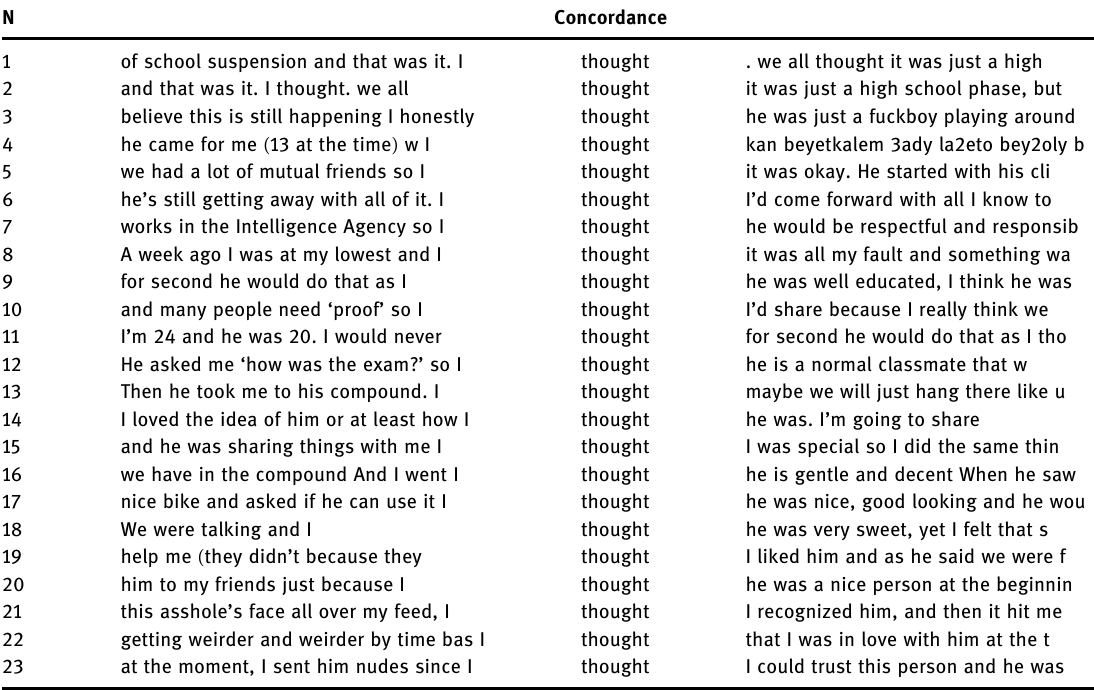
Table 7: Concordance lines for